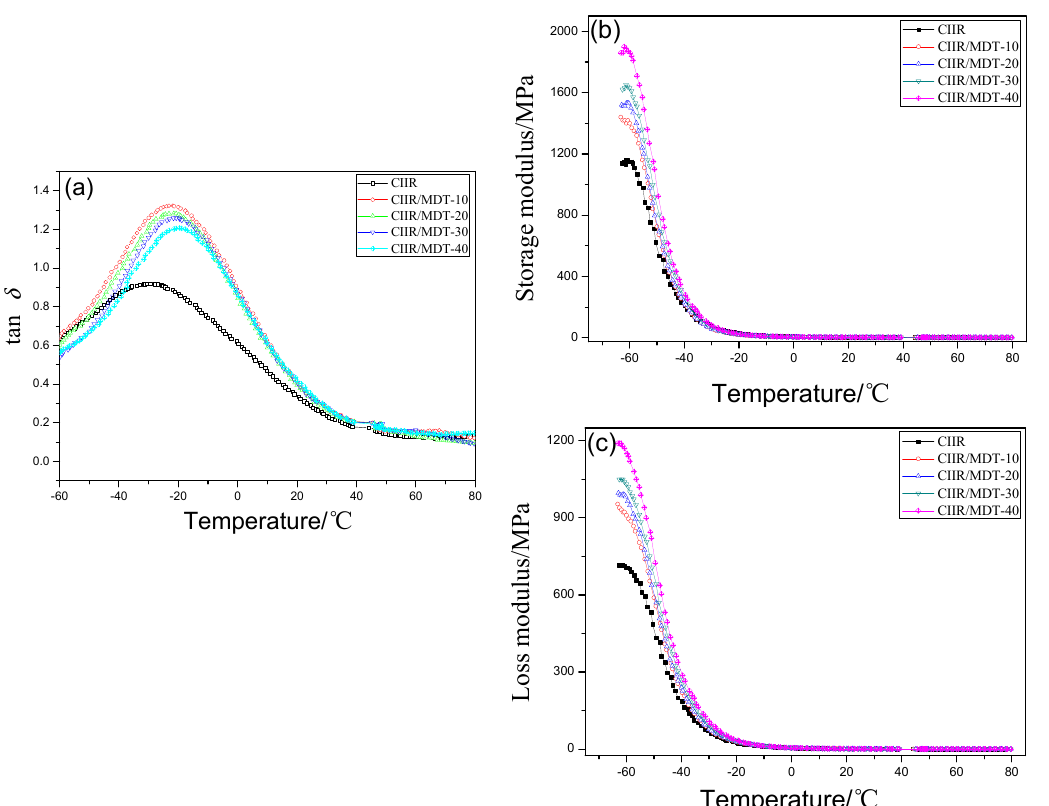
Figure 6. Dynamic mechanical properties of CIIR systems: ( a ) tan δ ; ( b ) elastic modulus; and ( c ) loss modulus.